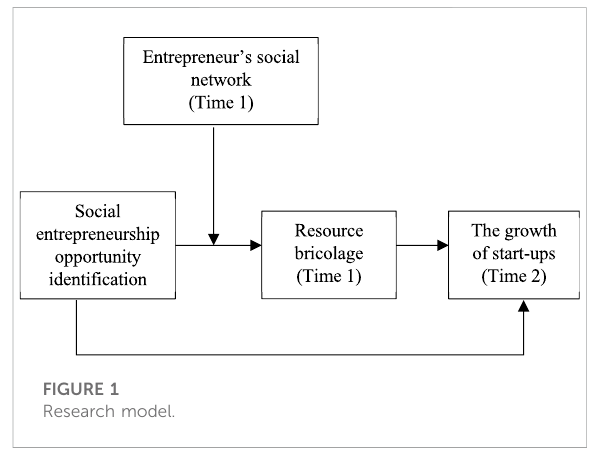
FIGURE 1 Research